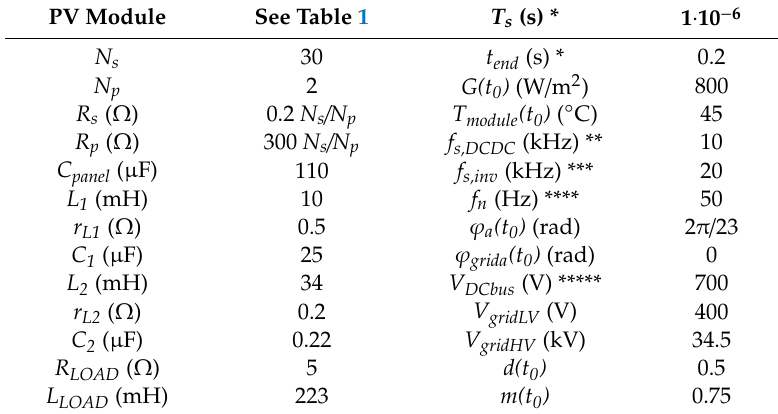
Figure 10. Simulation of a 18.9 kW PV subfield (2 strings in parallel, each string is composed by the series connection of 30 315 W PV modules). PV system configuration is represented in Figure 5, technical data of components are listed in Table 3. Irradiance is 800 W/m 2 , module temperature is 45 °C. At time 0.1 s control system forces non null reactive power. Comparison between detailed model and integrated state-space average model.